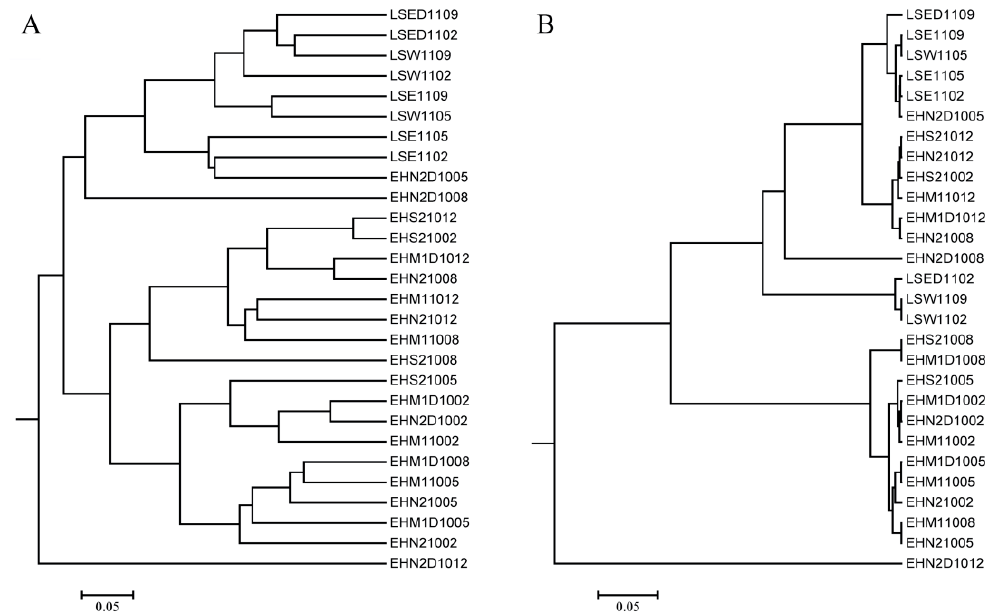
Figure 3. Cluster dendrograms based on membership (Jclass, A ) and structure (Jabund, B ) of the cyanobacterial community.